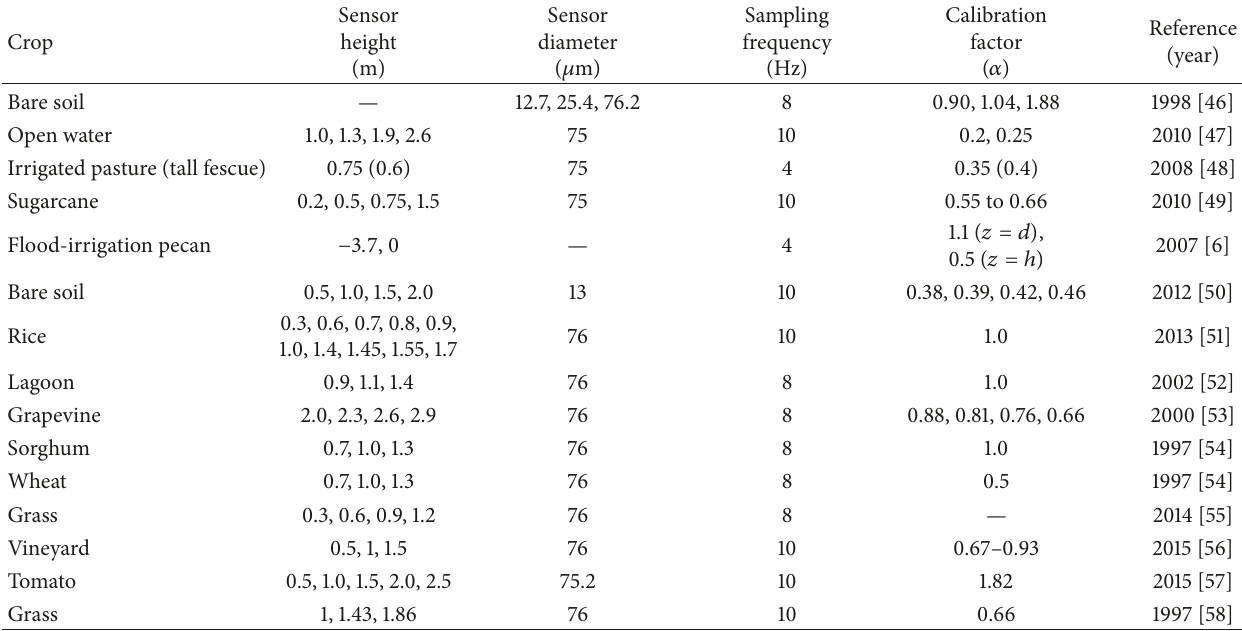
Table 1: Effect of different parameters on